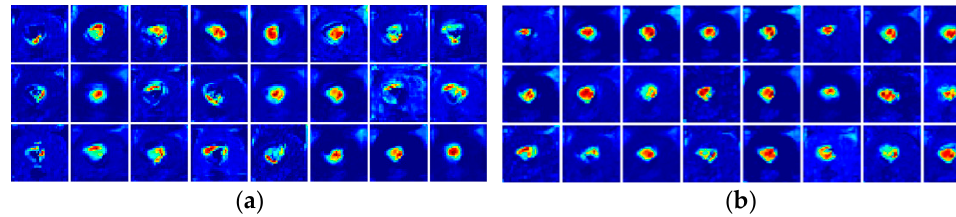
Figure 10. The visualization of the ResNet18 model and the CBAM-ResNet45 model. ( a ) The visual diagram of ResNet18. ( b ) The visual diagram of CBAMResNet45.